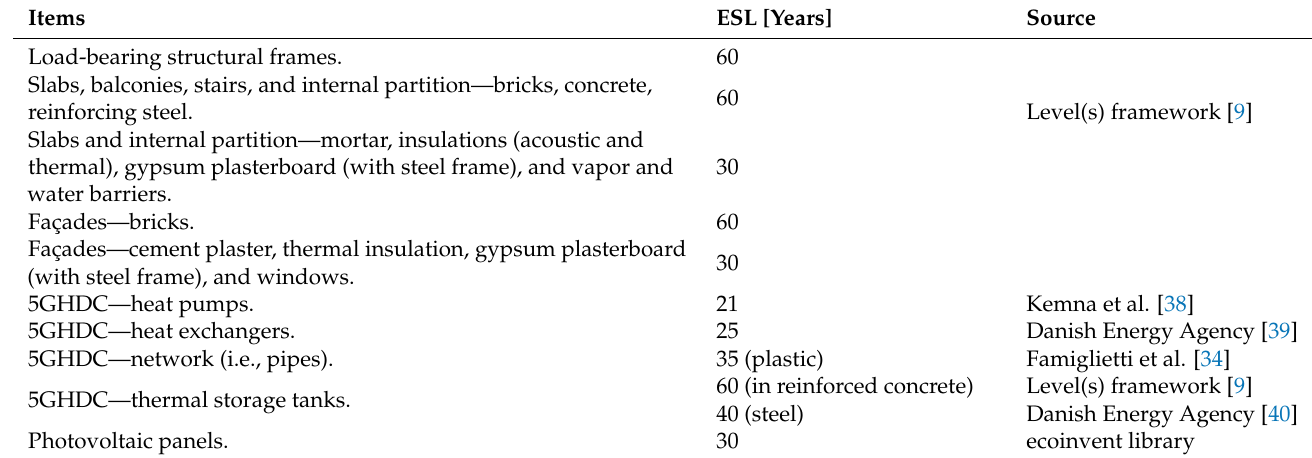
Table 2. Estimated service